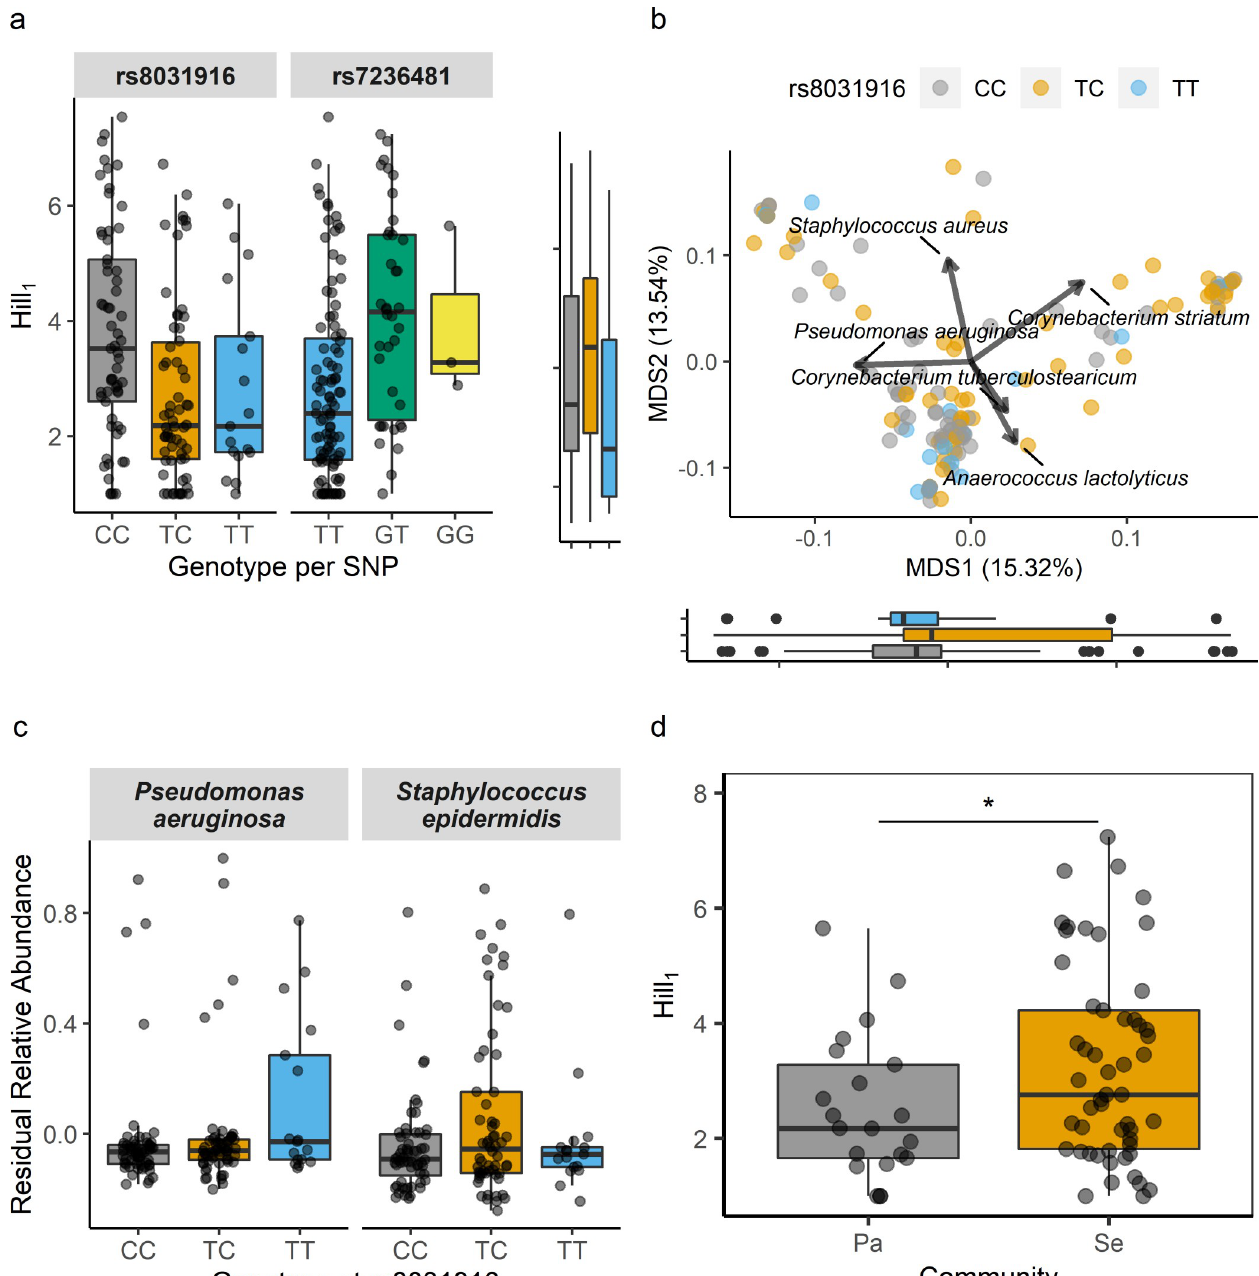
Fig 1. Patient genotype influences on different aspects of the chronic wound microbiome. a , Boxplot of Hill 1 diversity as a function of genotype at rs8031916 ( TLN2 ) and rs7236481 ( ZNF521 ), each explaining significant components of variation in the two-cohort mbGWAS. b , Distance-based redundancy analysis based on Bray-Curtis dissimilarities with relative abundance species effects indicated by vectors. rs8031916 significantly explained beta diversity (p < 0.01). The distribution of genotypes at rs8031916 across MDS1 and MDS2 are illustrated by boxplots. c , Boxplot illustrating how residual relative abundances of P . aeruginosa and S . epidermidis were significantly explained by rs8031916 (p < 0.05 for each). d , Communities in which P . aeruginosa (Pa) was present were significantly less diverse than communities in which S . epidermidis occurred (p <